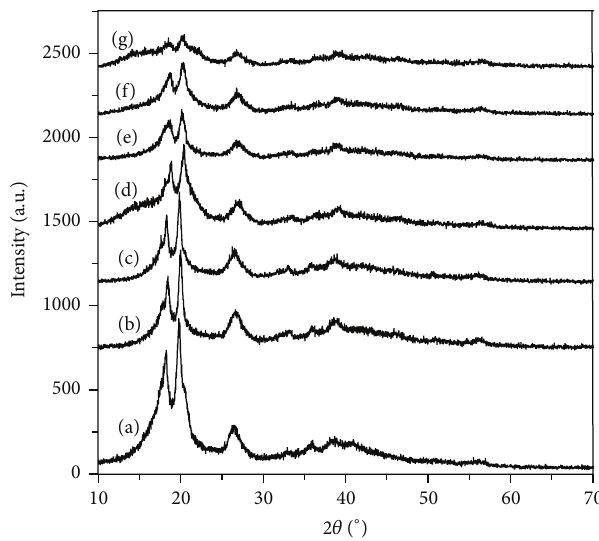
Figure 1: XRD patterns of PVDF powder (a) and PVDF scaffolds sintered at different laser energy density of (b) 0.66; (c) 0.96; (d) 1.26; (e) 1.56; (f) 1.86; (g) 2.16 J/mm 2 .